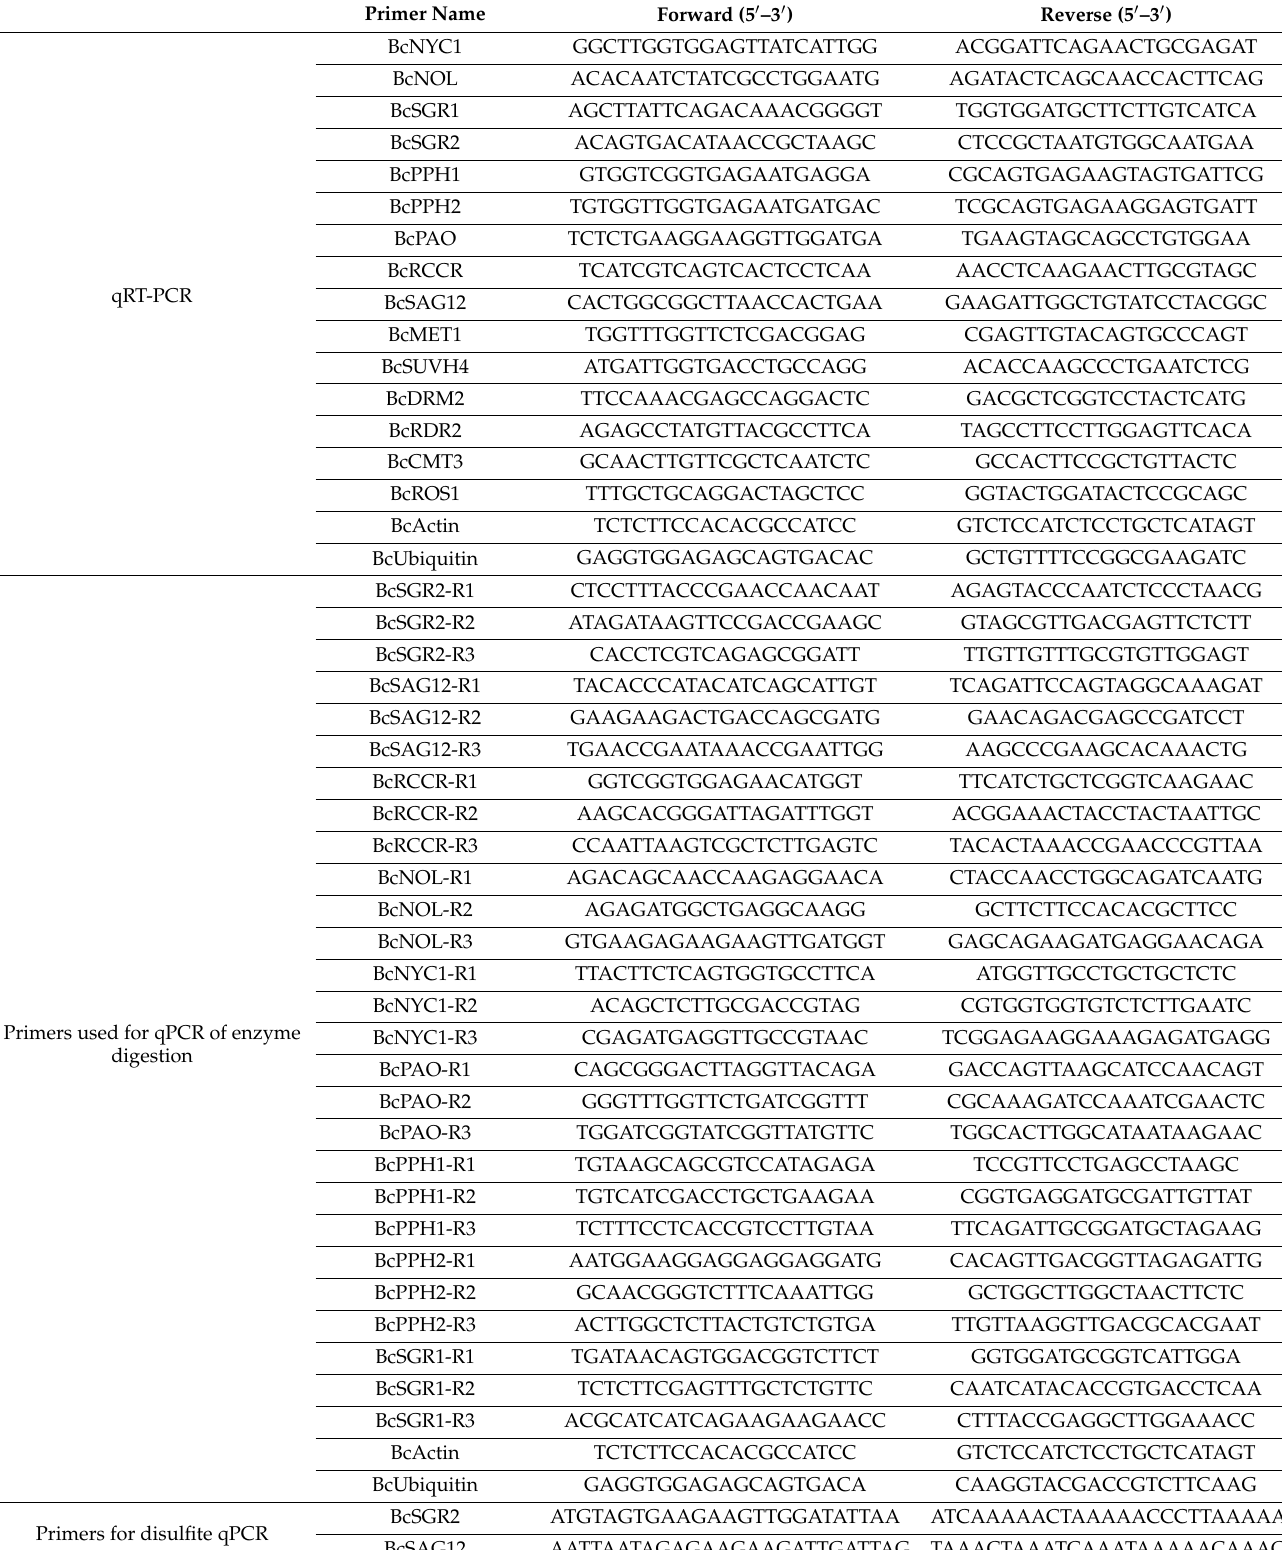
Table 1. Primer sequences used for PCR in this